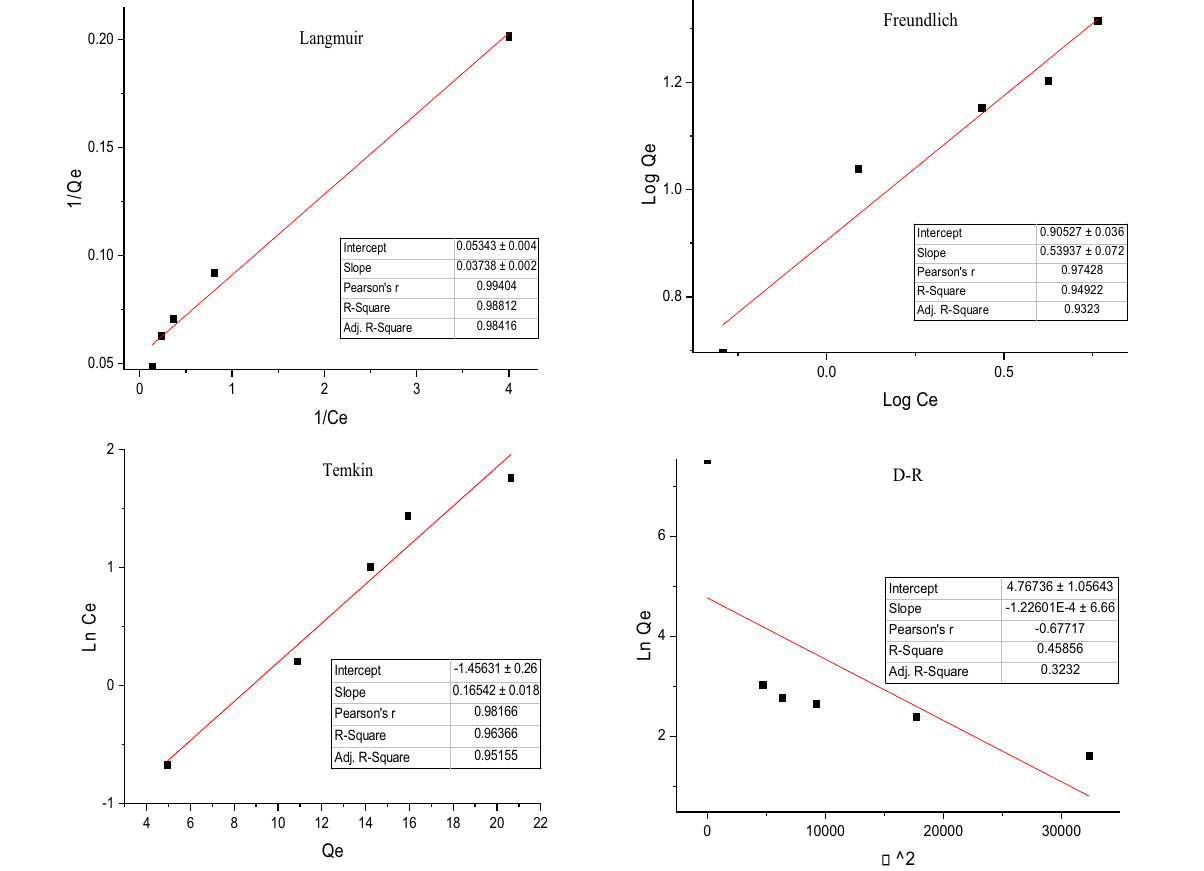
Figure 4. Linear ( a – d ) curves of the isotherm models of fluoride adsorption on the bivalve shell under the optimized condition. 0.005.0010.0015.0020.0025.00 0.00